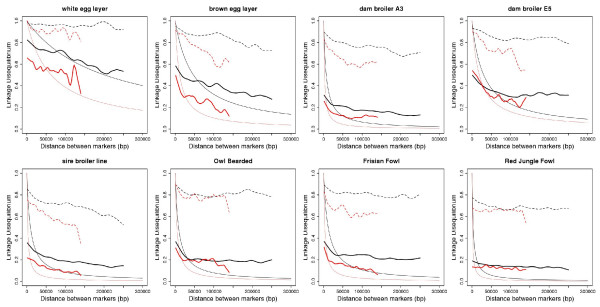
Fitted and observed values of LD versus physical distance (bp), for the macrochromosomes (black) and microchromosomes (red). Observed values for r2 are in thick lines (lowess fit through averages over a sliding window), Fitted values using the Sved equation [21] are thin continuous lines, and observed values for D' are in hatched lines (lowess fit through averages over a sliding window).